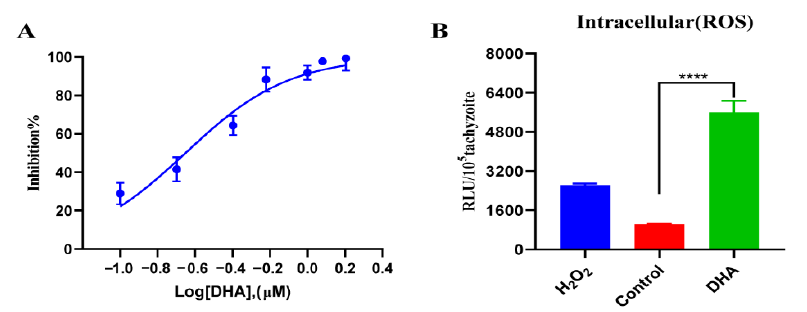
Figure 1. DHA treatment causing growth inhibition and excessive ROS accumulation in T. gondii . ( A ) Antiparasitic effect of DHA. Vero cells were infected with 1 × 10 5 TgRH-Luc tachyzoites and treated with different concentrations of DHA for 24 h. Percentage inhibition was calculated based on the relative RLU in each treatment group and DMSO control. ( B ) DCFDA determination of ROS levels of parasites under DHA treatment. Vero cells were infected with 4 × 10 5 TgRH-Luc tachyzoites for 12 h and then treated with DHA (0.88 µ M) for 24 h. Positive and solvent controls were treated with H 2 O 2 (200 µ M) or DMSO for 4 h, respectively. Results were based on RLU per 10 5 tachyzoites in each group. The stability and effectiveness of this method were validated in three independent experiments. Statistical analysis was performed using Student’s t -tests, and **** indicates p < 0.0001. ROS-dependent generation has been suggested as a possible signal for